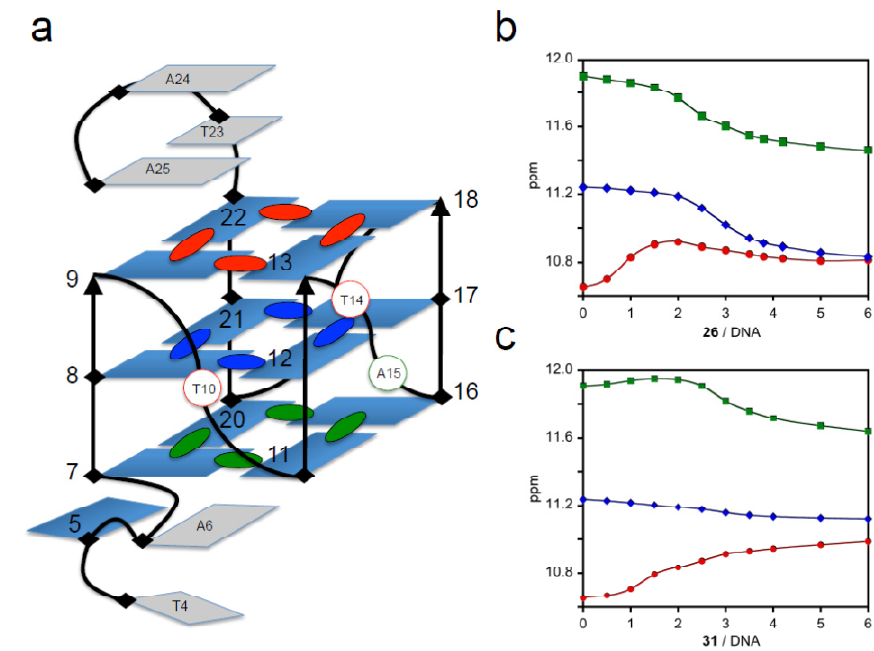
Figure 5. ( a ) Schematic structure of the c-myc quadruplex MYC22 adopted from [30]. For clarity the imino protons of the guanine tetrads are color coded. Red: 3 ʹ -end tetrad, blue: center tetrad, and green: 5 ʹ -end tetrad. Imino proton titration curves of 3 ʹ -end, middle and 5 ʹ -end tetrad for the parent cyanine ( 24 , b ) and the brominated analog ( 31 , c